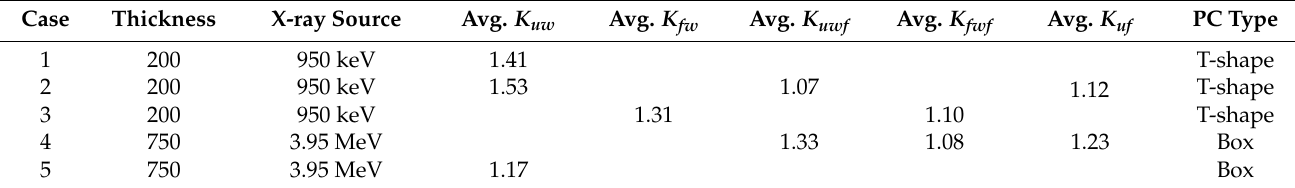
Table 7. Overall K ratio summary in different